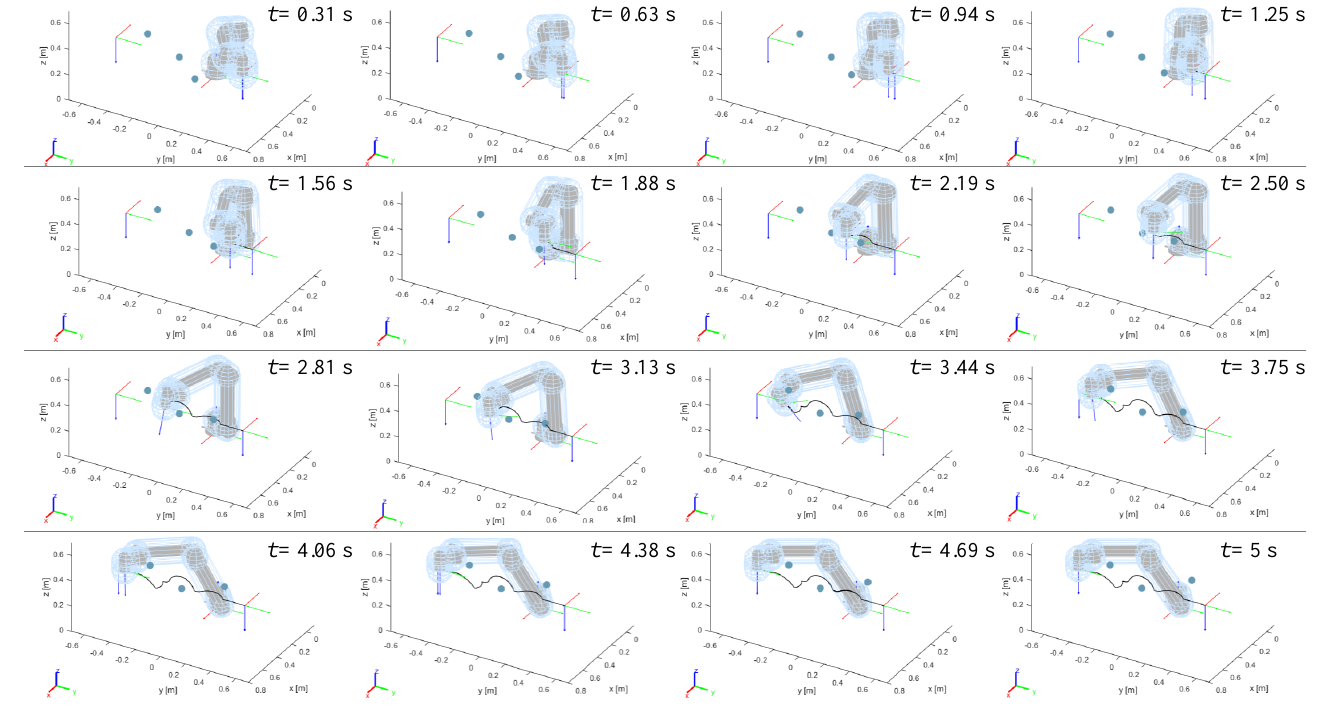
Figure 11. Avoidance of three obstacles while moving on a linear path.